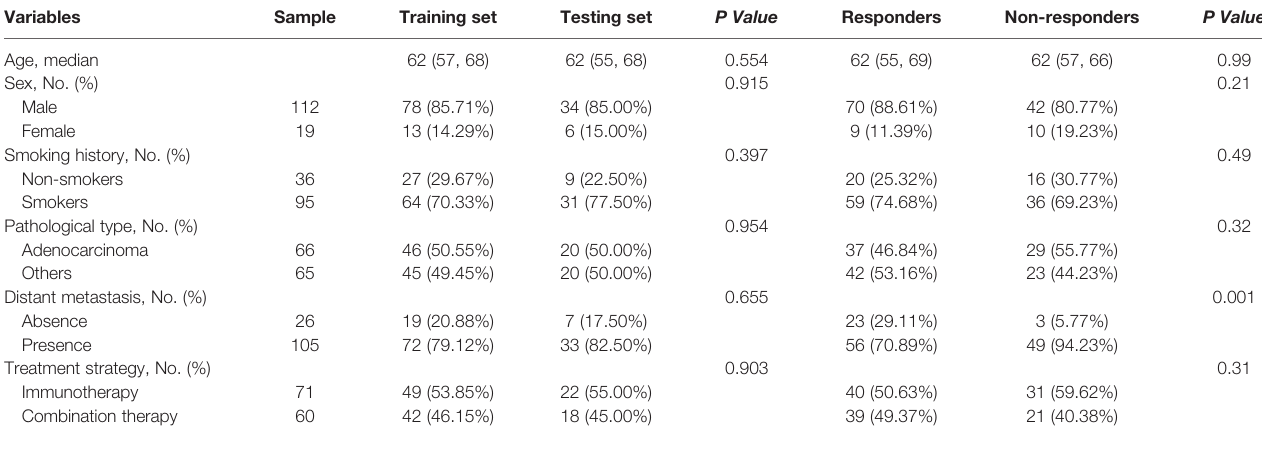
TABLE 1 | Baseline clinical characteristics comparison of the 131 cases between training set and testing set, and responders and non-responders.